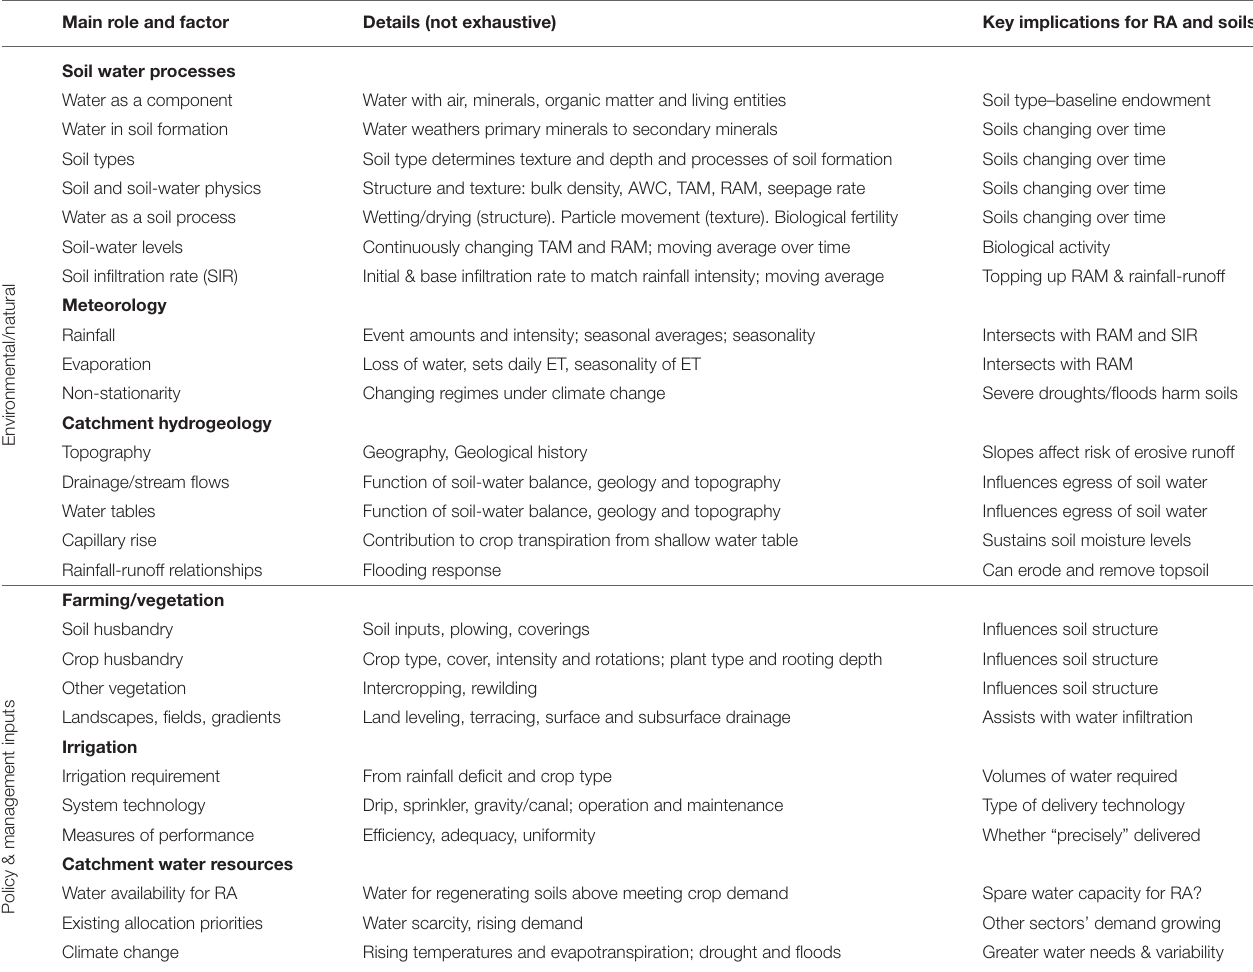
TABLE 2 | A system of RA, soil and water